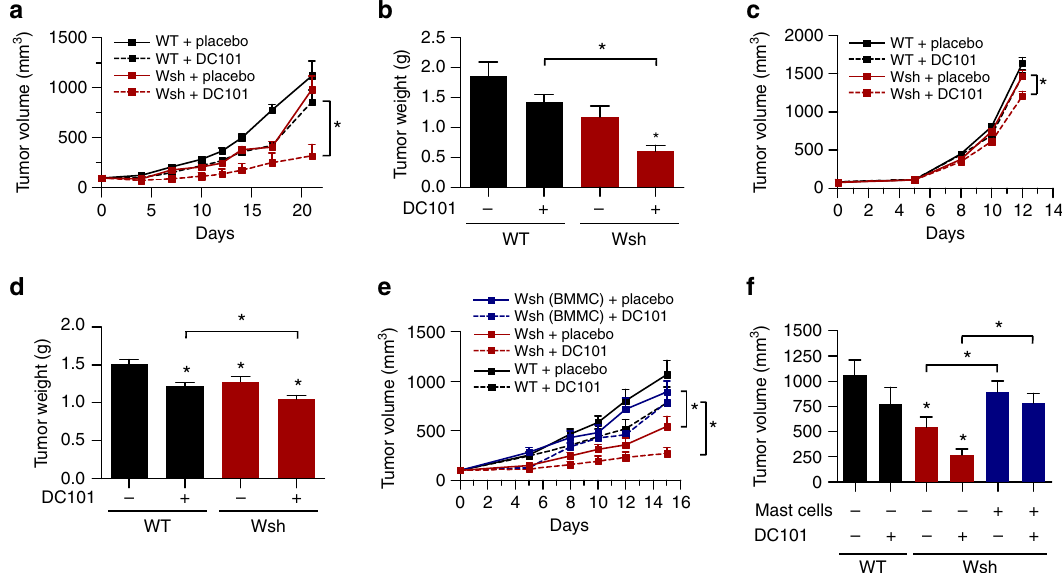
Fig. 1 Mast cells impair the ef fi cacy of AAT. a Subcutaneously growing Panc02 tumors. Cells were injected into the fl anks of C57Bl/6J (WT) or MC-de fi cient (Wsh) mice and the animals received treatment with placebo or 20 mg/kg DC101 ( n = 8/8/5/5; * p < 0.05; two-way ANOVA). b Weight of end-stage Panc02 tumors at day of euthanasia ( n = 8/8/5/5; * p < 0.05; one-way ANOVA). c Subcutaneously growing EL4 tumors. Cells were injected into the fl anks of C57Bl/6J (WT) or MC-de fi cient (Wsh) mice and the animals received treatment with placebo or 20 mg/kg DC101 ( n = 5/5/5/5; * p < 0.05; two-way ANOVA). d Weight of end-stage EL4 tumors at day of euthanasia ( n = 5/5/5/5; * p < 0.05; one-way ANOVA). e , f Kinetic ( e ) or end-stage ( f ) tumor volume of subcutaneously growing Panc02 tumors with or without adoptive transfer of MC. After randomization animals received treatment with placebo or 20 mg/kg DC101 ( n = 9/9/7/6/7/5; * p < 0.05; two-way ANOVA and one-way ANOVA). Results are shown as representative means ±